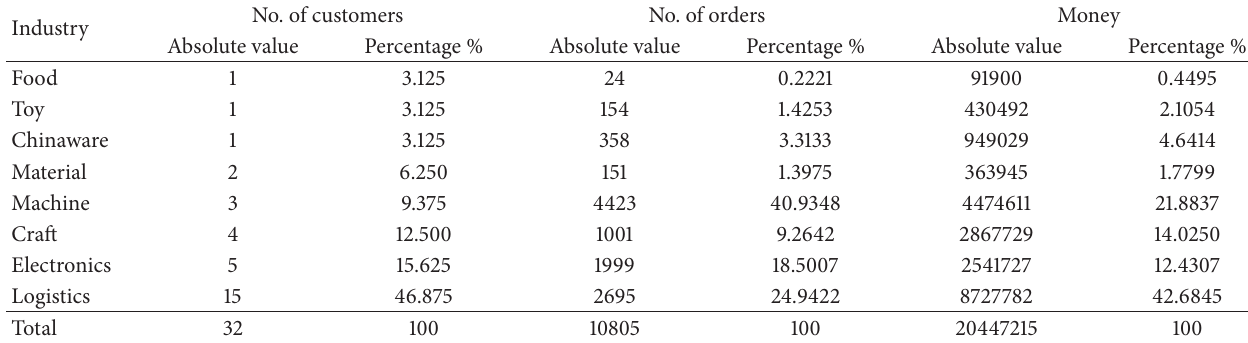
Table 1: Business data by